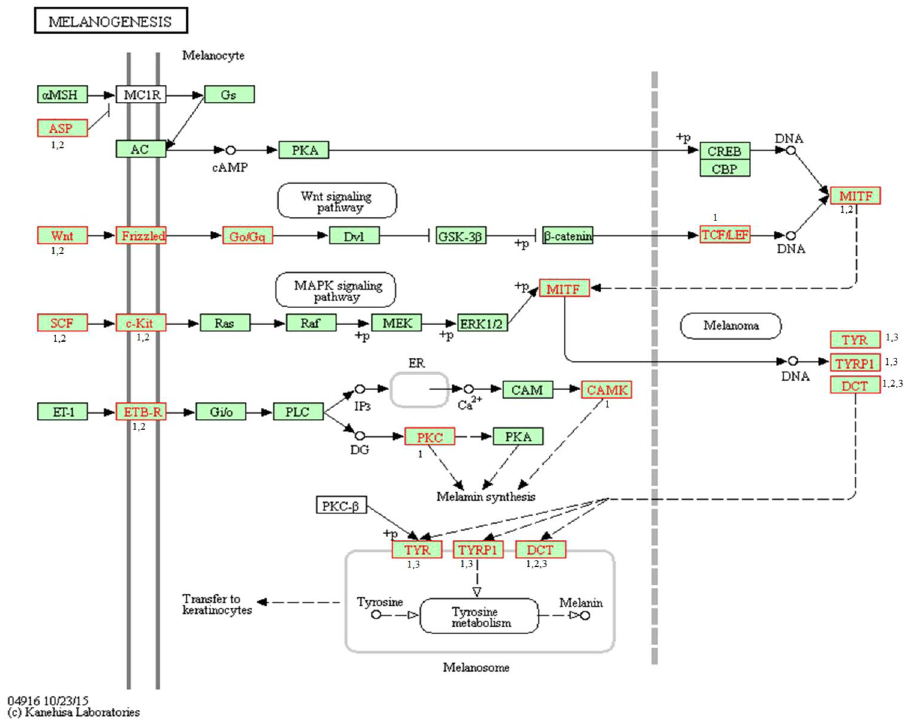
Figure 2. Differentially expressed coat color genes in Changthangi Pashmina goat and their involvement in melanogenesis signaling pathway (Adapted from ref. 18 ). DEGs are shown in red coloured frames. Number (1, 2, and 3) represents contrast groups. 1 Black Vs White. 2 Black Vs Brown. 3 White Vs Brown.